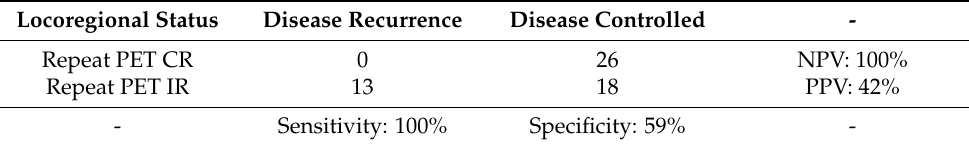
Table 3. Predictive values of repeat post-treatment PET/CT for persistent locoregional